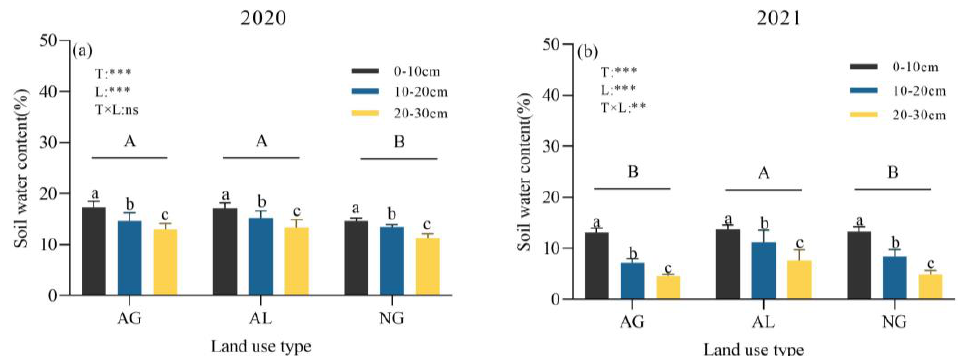
Figure 1. Soil volumetric water content at 0–10 cm, 10–20 cm, and 20–30 cm soil layers of different land use types in 2020 ( a ) and 2021 ( b ). AG: artificial grassland, AL: cropland, NG: natural grassland,